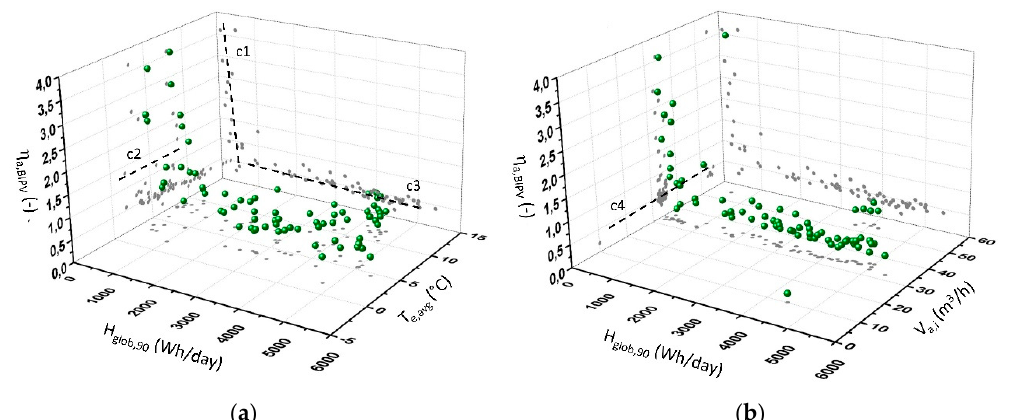
Figure 12. Average daily efficiency of solar radiation utilization for preheating of the supply air for space ventilation; ( a ) impact of the daily solar radiation H glob,90 and average daily outdoor air T e,avg ; ( b ) impact of the solar radiation and ventilation air flow rate , a in V